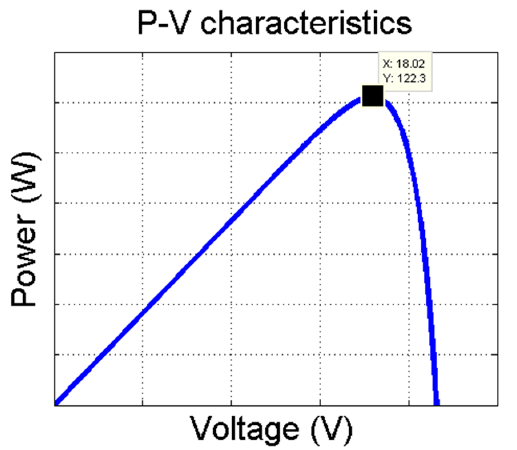
Figure 1. P-V characteristics of a photovoltaic module.